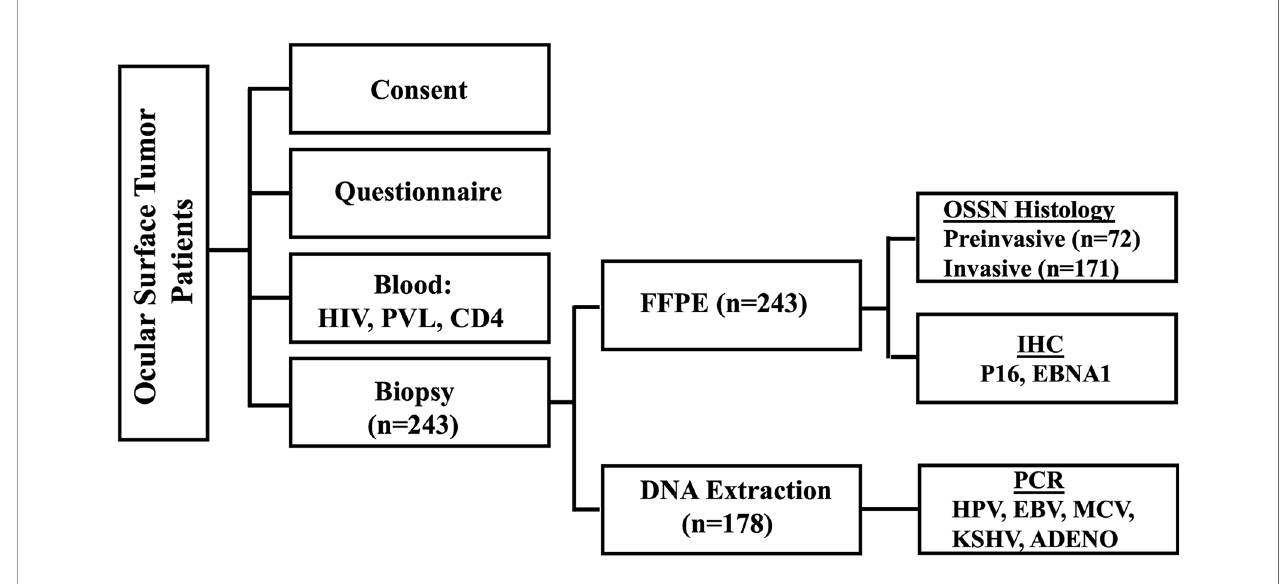
FIGURE 1 | Experimental